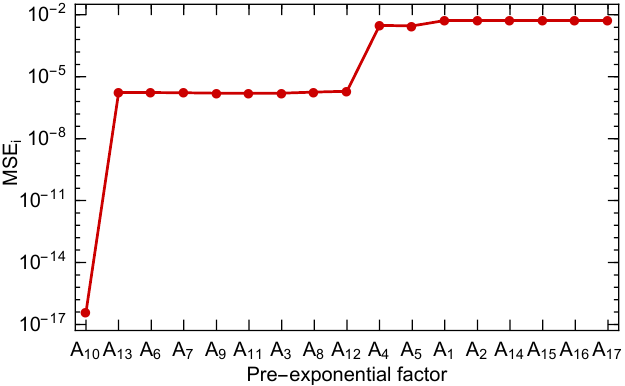
Figure 2. The mean-squared error MSE i produced during each step of removing the least significant pre-exponential factor A i . The model was tested at T = 90 ◦ C and initial conditions [ Fe 2 + ] = 10 ppm and [ H ] = 1 mM with simulated time t max = 100 h [4]. The final reduced model (RM) is achieved after the O 2 2 elimination of nine reactions (after removing reaction R 12 ,pre-exponential factor A 12 on abscissa) with the MSE i < 10 − 5